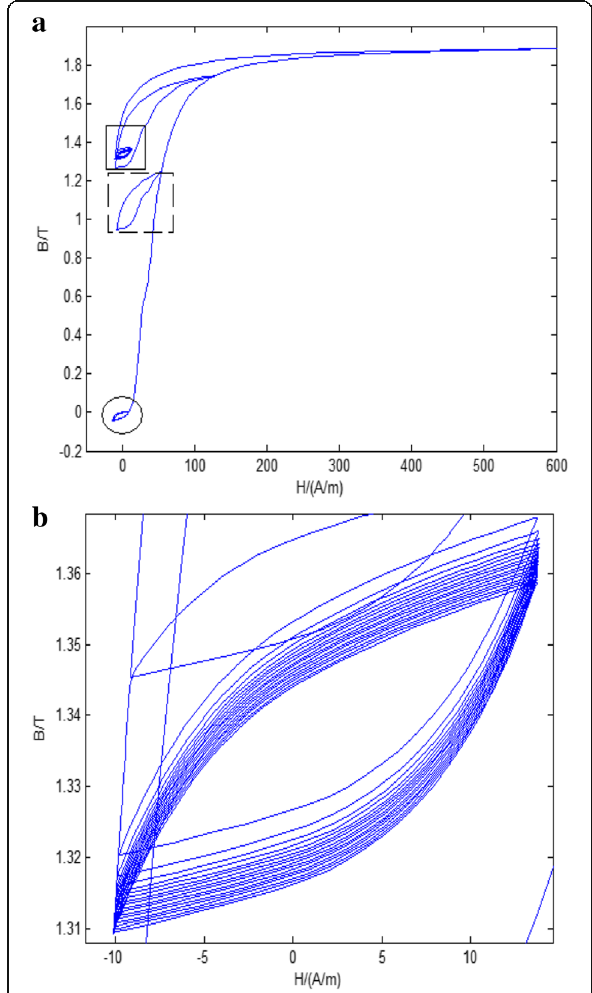
Fig. 19 Closed core magnetization curve. a whole process b ending part